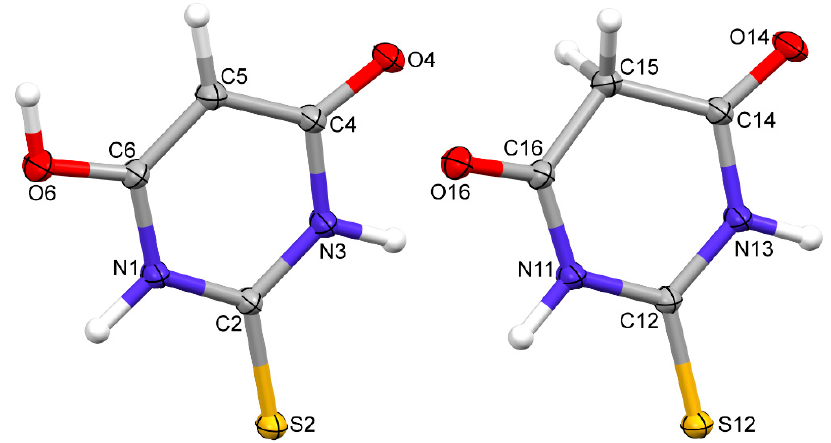
Figure 1. Perspective views of two symmetry-independent molecules of TBA; ellipsoids are drawn at the 50% probability level and hydrogen atoms are shown as spheres of arbitrary radii.